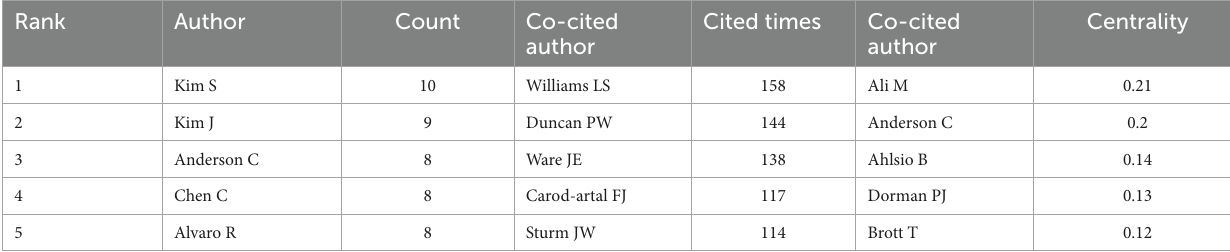
TABLE 1 Top five active authors and co-cited